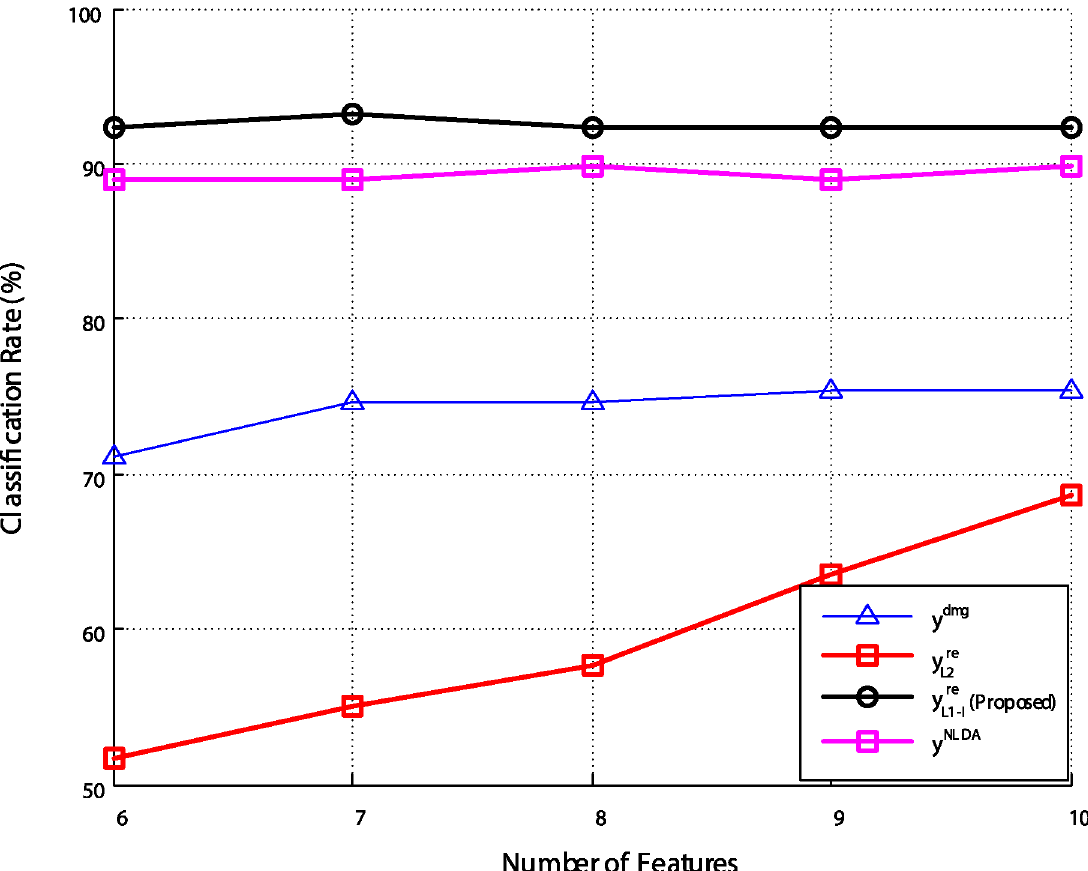
Fig 11. Recognition rates for various dimensions of the feature space.